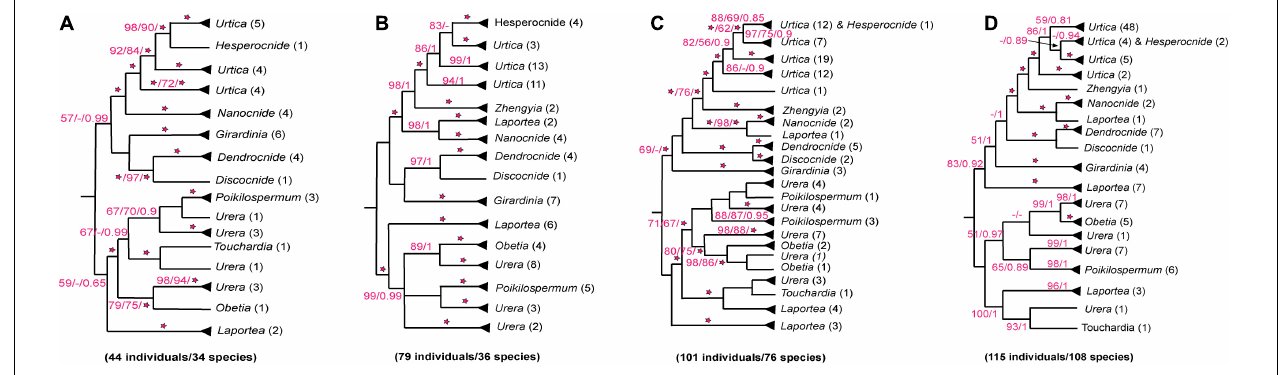
FIGURE 1 | Alternative relationships of Urticeae based on combined loci data from previous analyses . (A) Wu et al. (2013): Maximum likelihood (ML)/Maximum parsimony (MP)/Bayesian inference (BI) analyses based on nuclear, chloroplast, and mitochondrial loci; (B) Kim et al. (2015): MP/BI tree inferred from chloroplast and nuclear DNA data; (C) Wu et al. (2018): ML/MP/BI tree inferred from nuclear, chloroplast, and mitochondrial data; (D) Huang et al. (2019): MP/BI analyses based on chloroplast and nuclear data. Numeric values besides each genus correspond to the total number of accessions sampled per genus and the number below each figure represents the total number (individual/species) of Urticeae samples used in each respective analysis. “*” indicates full support; “–“ indicates no support in (A,C) , support values of < 75 (MP) and < 0.95 (BI) in (B) , and support values of < 50% (MP) and < 0.7 (BI) in (D)